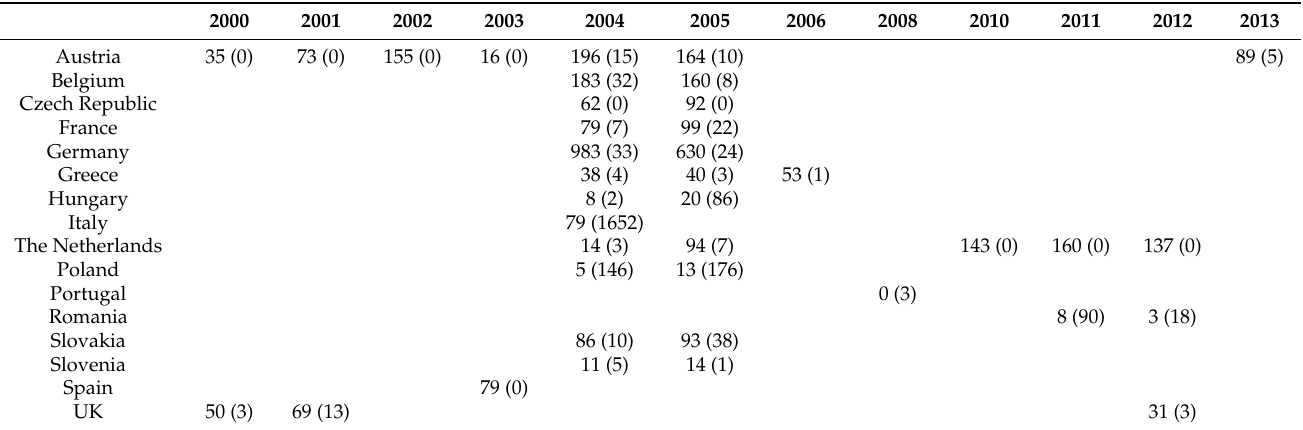
Table A1. Sample and number of detections per country and year for feed